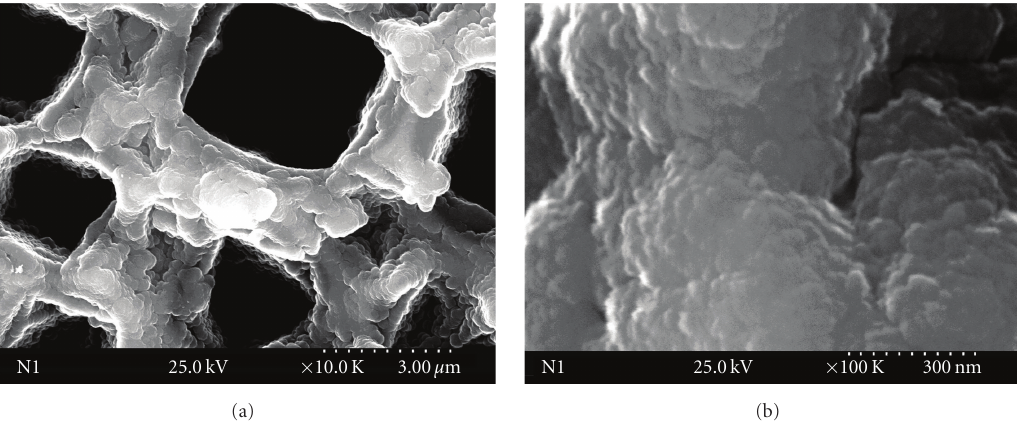
Figure 6: SEM images of undoped NCD grown on n-type PS sample. The magnification was increased from (a) to (b) for better visualization of